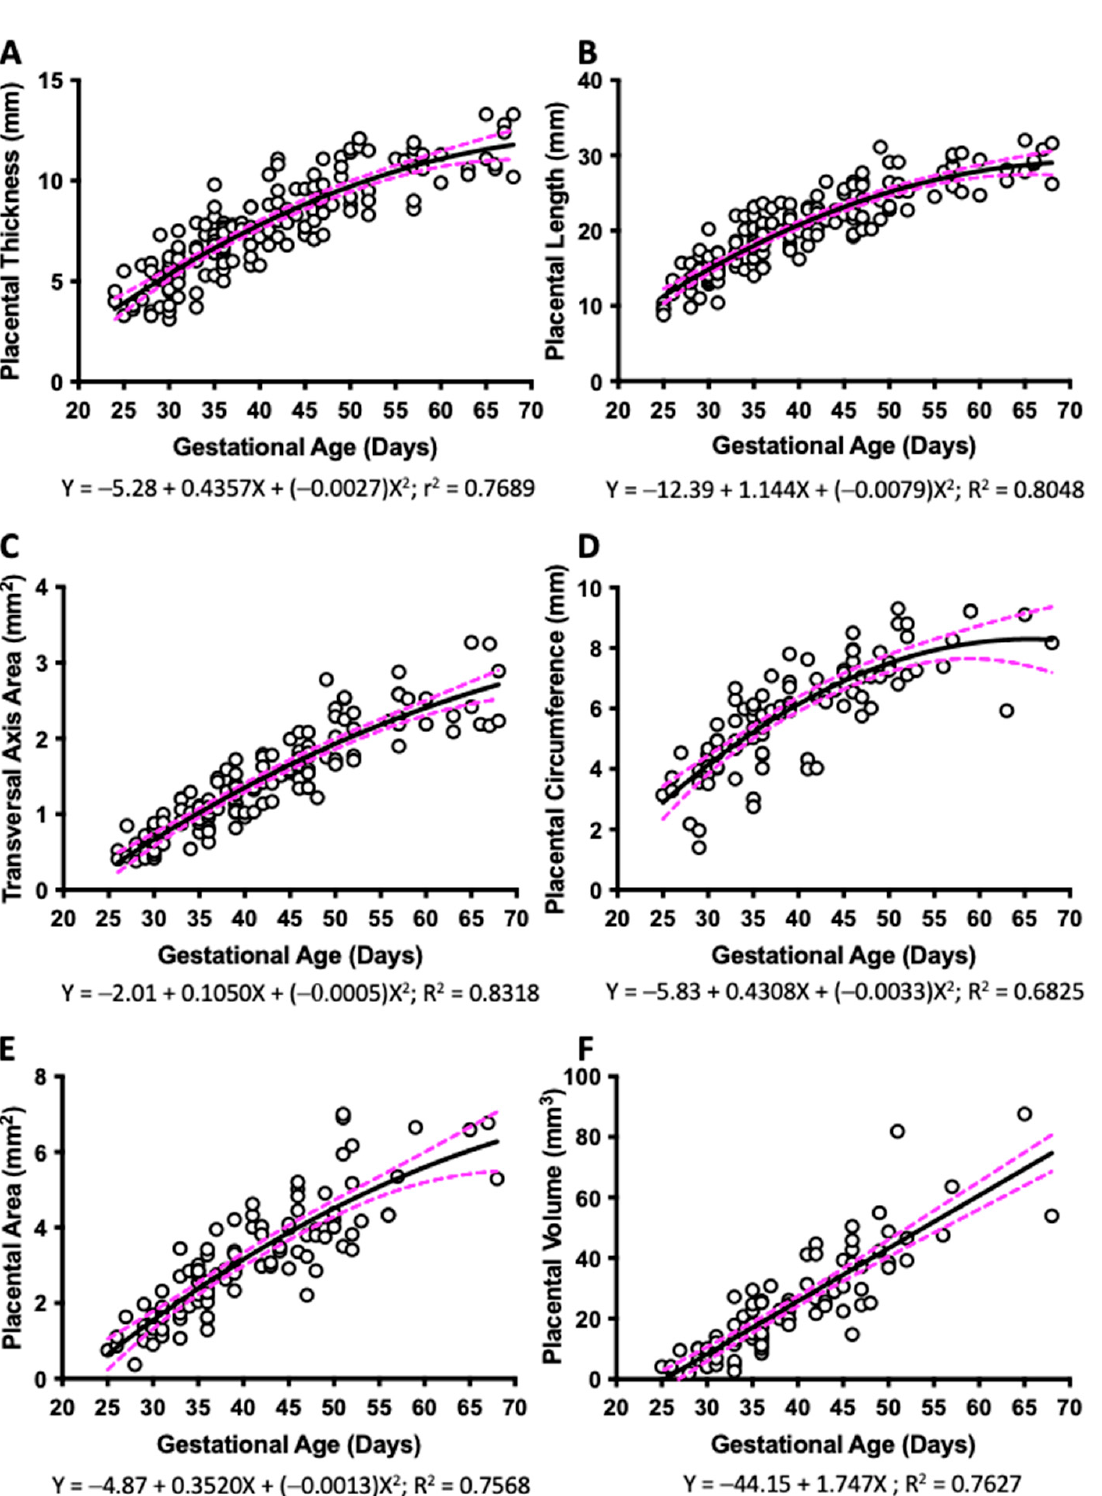
Figure 2. Placental biometry across pregnancy. Guinea pig placental ( A ) thickness, ( B ) length, ( C ) transversal area axis, ( D ) discoid perimeter, ( E ) discoid area, and ( F ) estimated placental volume, and their best fit from gestational day 25 to the end of pregnancy. Each dot represents an individual measurement (n = 47 from 19 litters). Black line = data best fit. Magenta dashed lines = 95% CI.